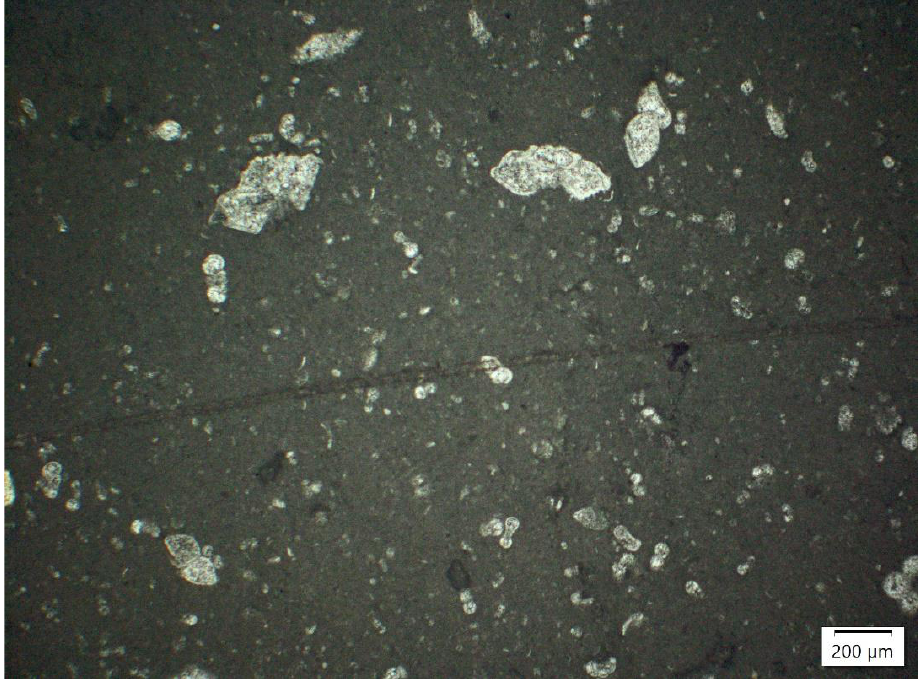
Figure 6. Thin section photomicrograph depicts the co-existence of Globotruncana stuarti de Lapparent [56], Globotruncana aegyptiaca Nakkady [57], and Globigerinidae determining the K-Pg boundary.